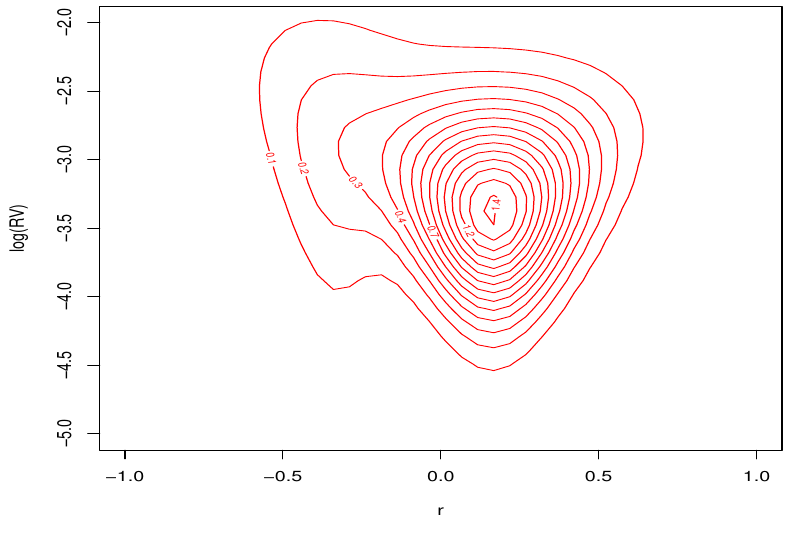
Figure 14. Predictive density for r ,log ( RV ) for low volatility I t − 1 , t = 1964 :